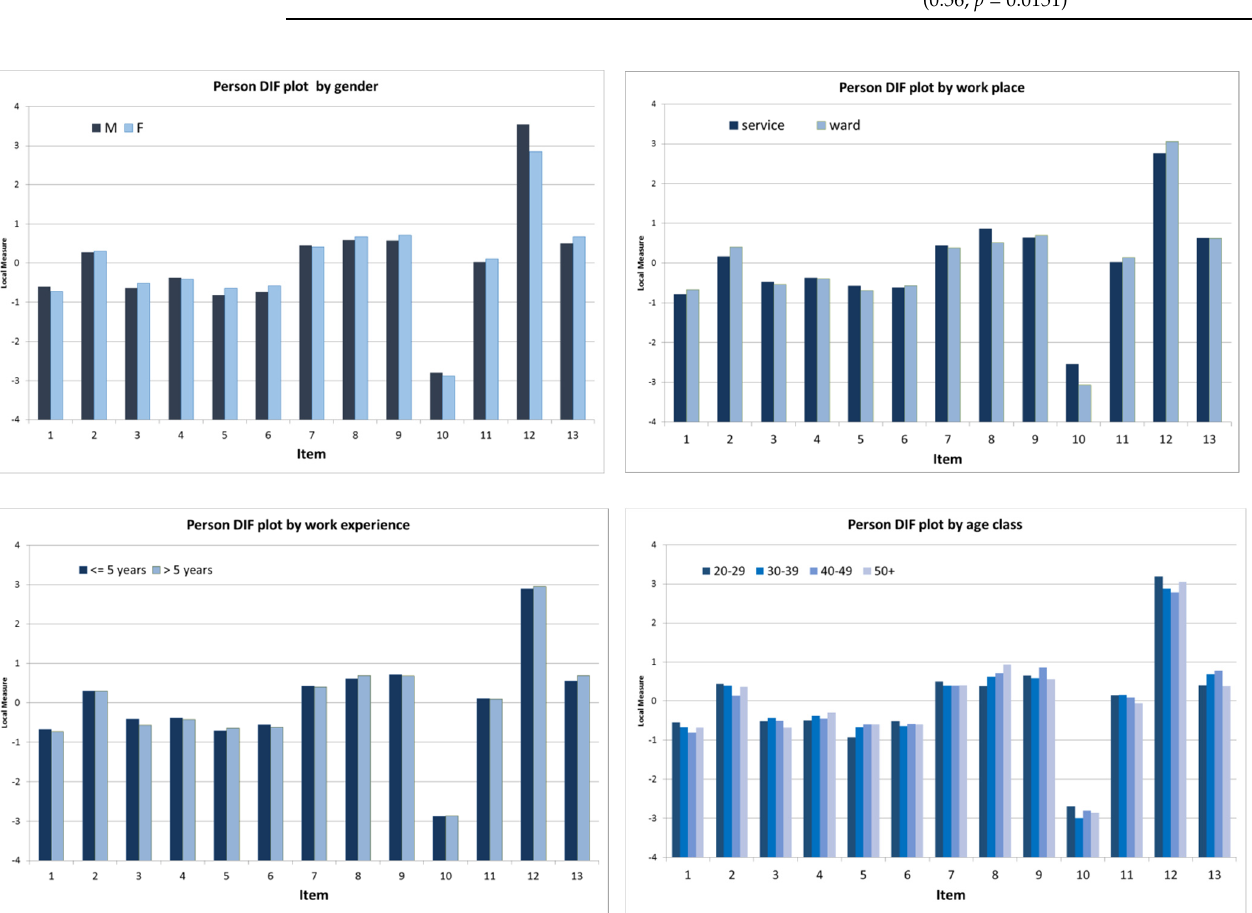
Figure 2. Person DIF plots according to gender, work experience, workplace, age range, and lan- guage . Notes: gender = F/M; age range = 20–29 years, 30–39 years, 40–49 years, 50+; workplace = working on a ward or in a service; work experience = ≤ 5 or >5 years; language = DE/IT. 4. Discussion The aim of this study was to explore the psychometric properties of the German and Italian versions of the adapted IPC scale, applying Rasch analysis as recommended by Walters [6] and Peltonen [8]. The results obtained in this study regarding reliability measures and separation in- dexes were good and confirmed the reliability of the scale in measuring interprofessional